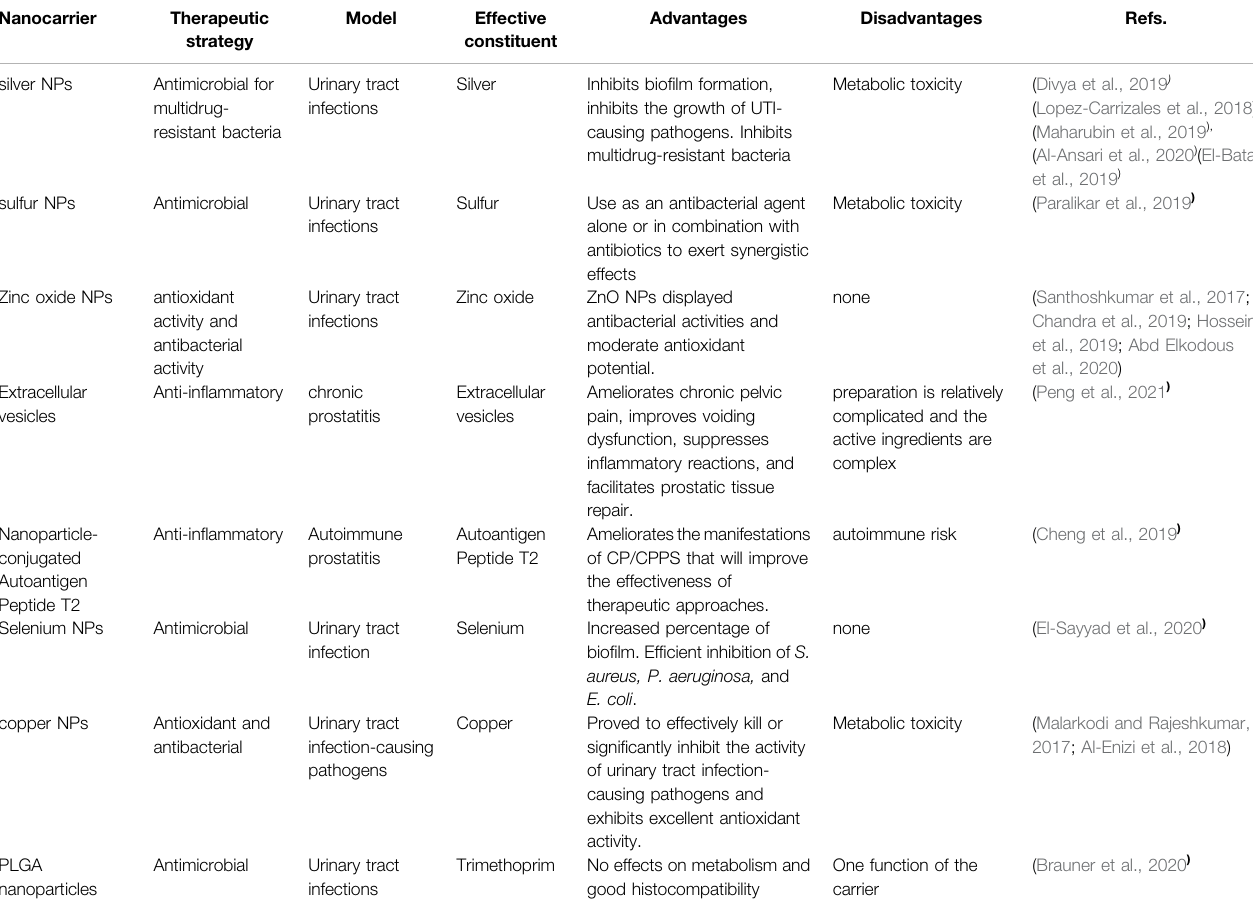
TABLE 1 | The application of functionalized nanomaterials in